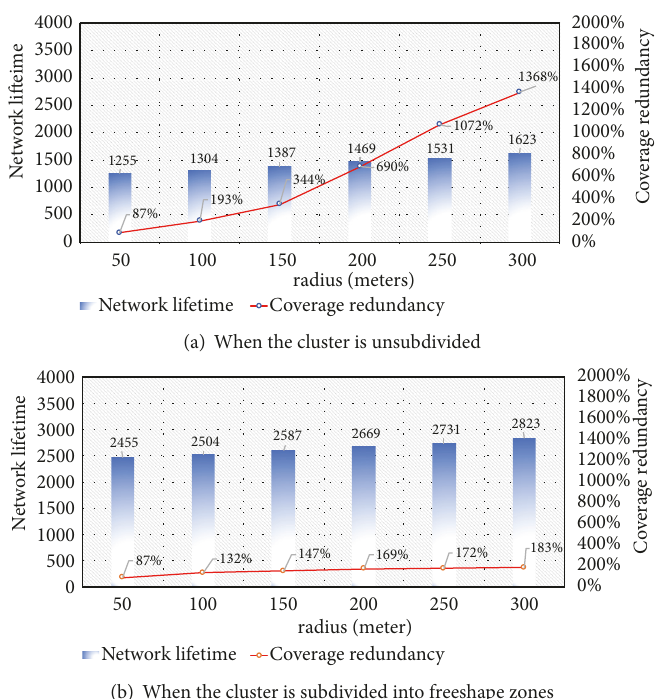
Figure 10: Relationship of the coverage redundancy, radius, and the network